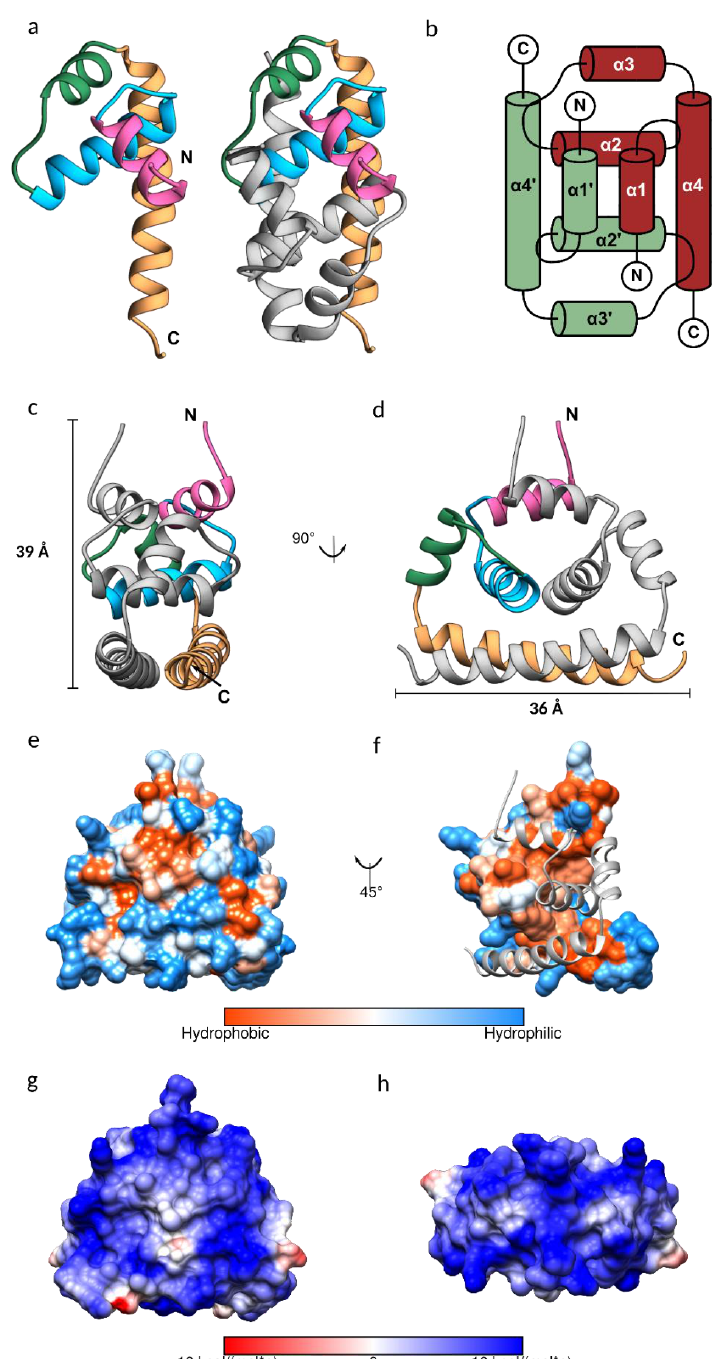
Figure 2. The structure of the Japanese encephalitis virus (JEV) capsid protein. ( a ) Ribbon model of the JEV capsid monomer, colored by the 1–4 α helices in pink, blue, green, and sandy brown, respectively. The dimeric assembly is also shown with the second subunit in grey. ( b ) Topology diagram of the JEV capsid dimer. The α -helices of one subunit are indicated with an apostrophe symbol. ( c,d ) Side view of the JEV capsid dimer with the dimension of 3.9 × 3.6 nm. ( e,f ) Hydrophobic surface colored on the Kyte–Doolittle scale. ( e ) Hydrophobic surface of the dimer. ( f ) Hydrophobic surface of the monomer with the opposing subunit is shown as a ribbon model. ( g,h ) Coulombic surface coloring of the capsid dimer side view and top view, respectively. The surface shows a symmetric pattern consistent with the homodimers. Electrostatic surface potential was calculated according to Coulomb’s law, with thresholds ± 10 kcal /